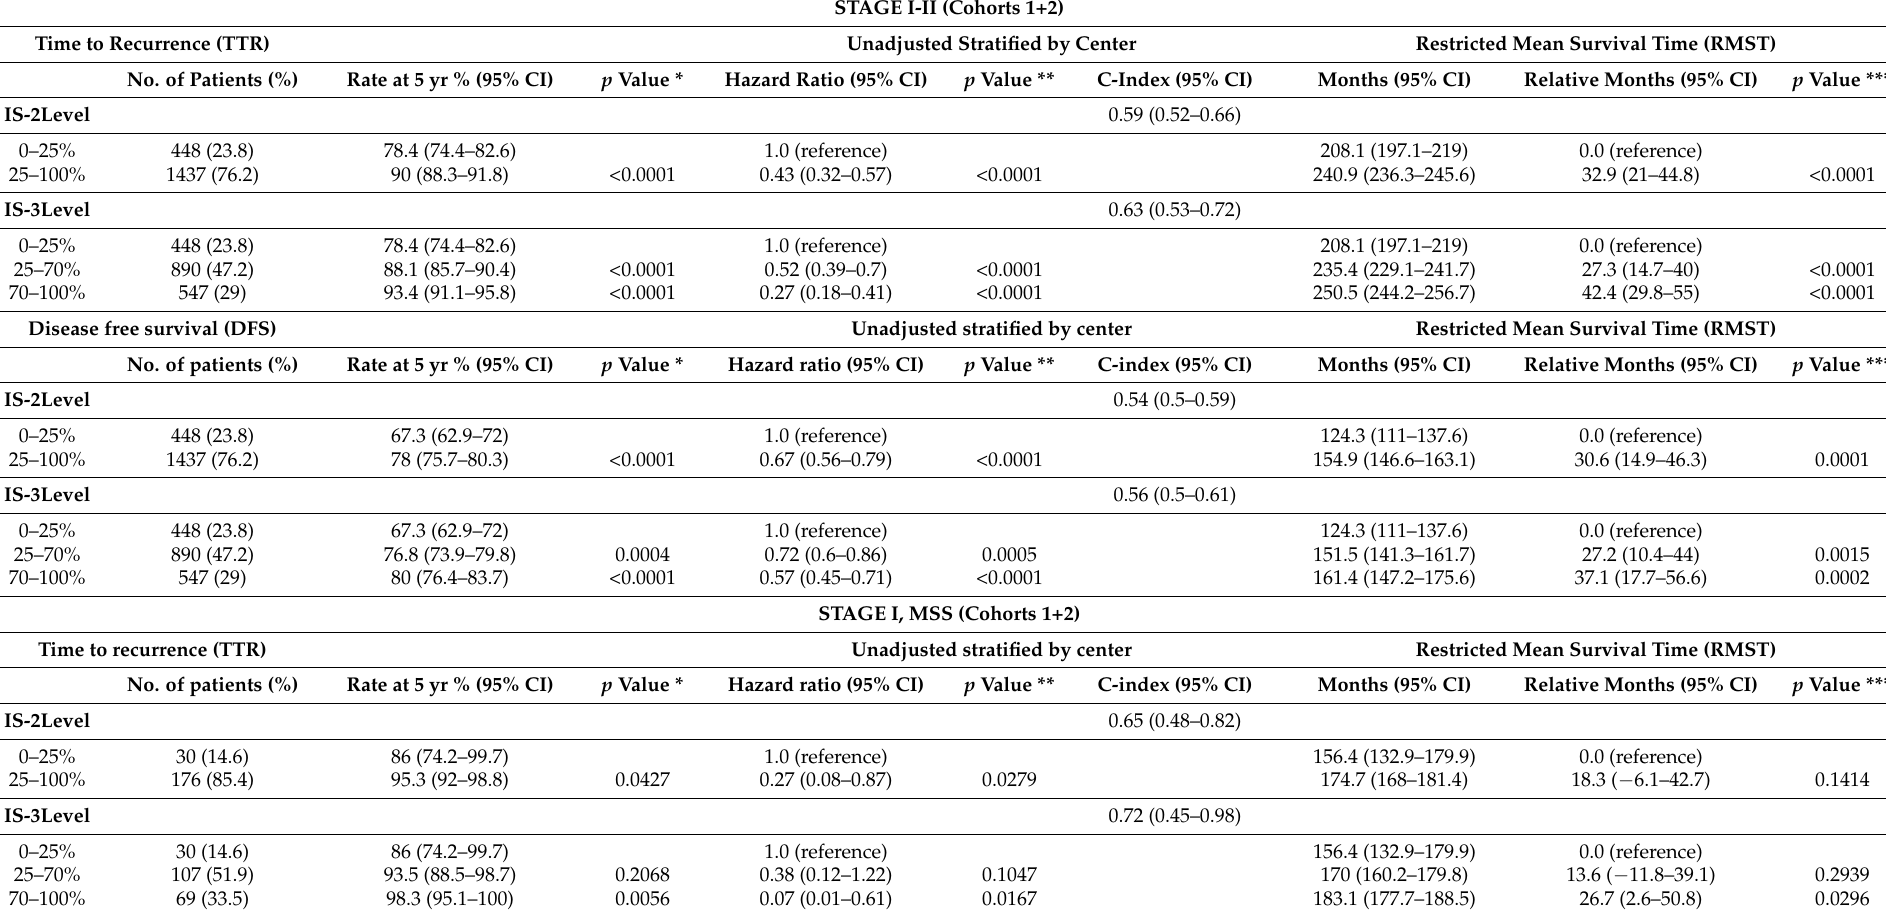
Table 1. Univariate Analysis